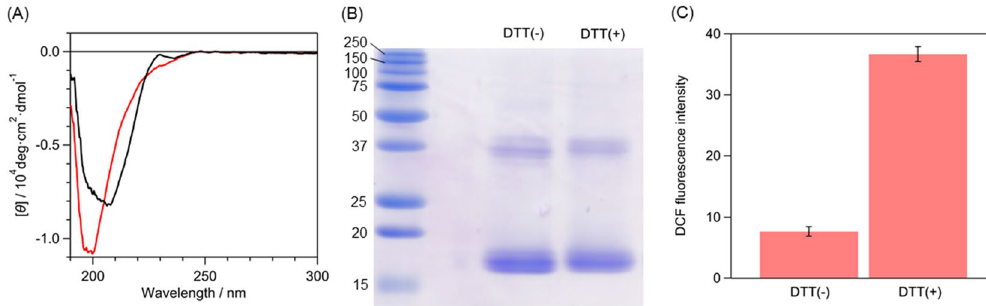
Figure 6. Reduction of the intramolecular disulfide bond of apo-G93A. ( A ) CD spectra, ( B ) non-reducing SDS-PAGE, and ( C ) DCF fluorescence intensities of apo-G93A after the incubation at 4 °C for 24 h in